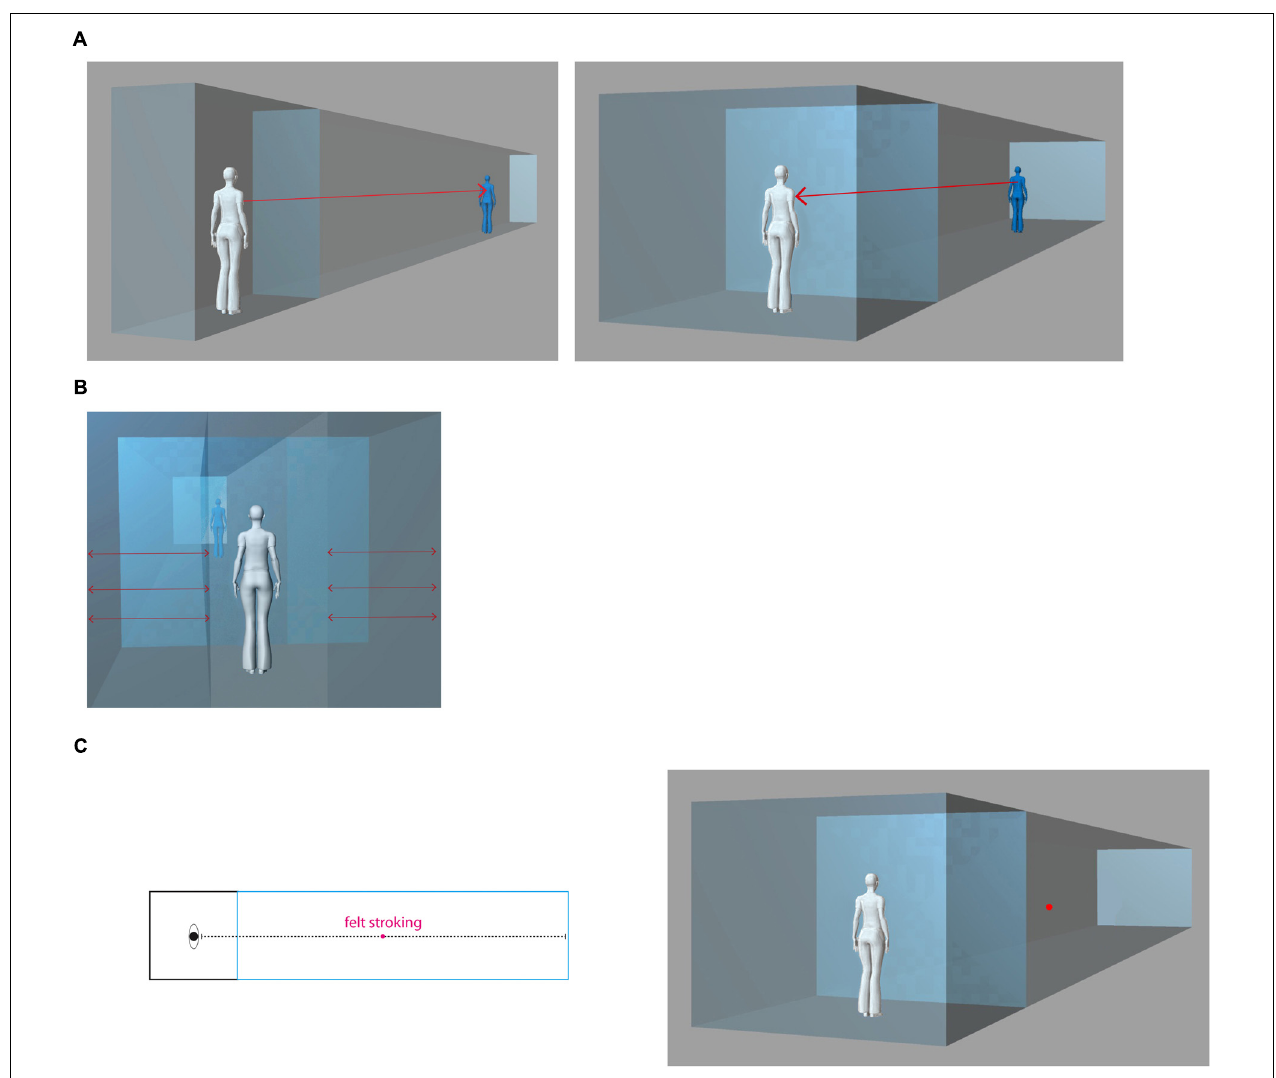
FIGURE 6 | Architectonic self-consciousness. The subjective perception of depth was significantly modulated by a referred somatosensory sensation toward the virtual interior evoked by the avatar. The presence of the avatar altered the perception of both, body and space in the augmented interiors. (A) Own body drifting toward the avatar depended in Experiment 1 only on stimulation with higher responses for synchrony (Question 4); the backward drift of the avatar was induced by stimulation and interior with higher responses in large and synchrony (Question A7). (B) The Full-Body-Illusion in Experiment 1 induced a sensation of contraction (Question B5) and touch (Question B6) through the sidewalls evoked by stimulation. (C) The touch was felt halfway between the physical body and the virtual front wall (Question A6) depending on an interaction between stimulation and interior for large and synchrony in Experiment